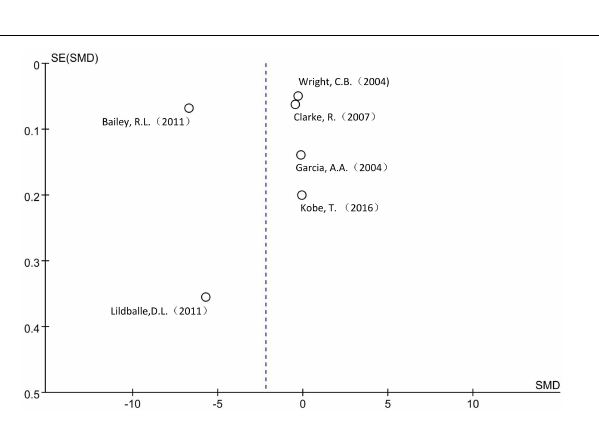
FIGURE 2 | Forest plot of the association between MMA and cognition in the six cross-sectional studies.